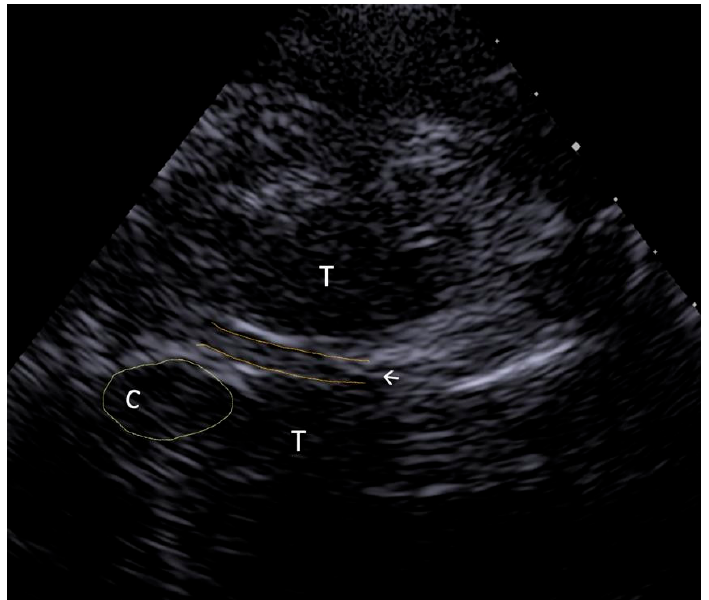
Figure A2. Transcranial ultrasound of a healthy subject performed with a 2.7 MHz transducer, transthalamic axial section. Hypoechoic ovoid silhouettes correspond to normal thalamic nuclei (T) and caudate nucleus (C). The arrow indicates the normal 3rd ventricle, as a hypoechoic tubular structure with hyperechoic margins.